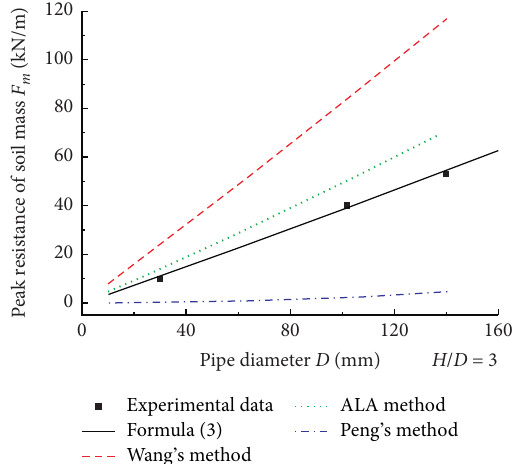
Figure 15: Comparison of model test results and formula results, in which H/D �